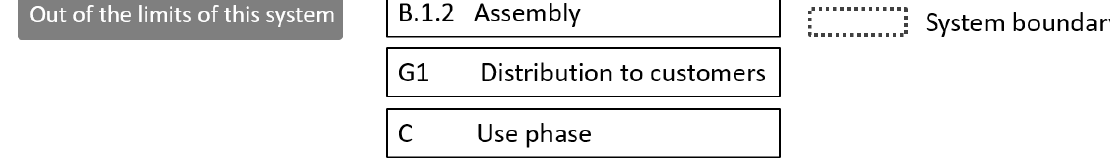
Figure 2. System boundaries.